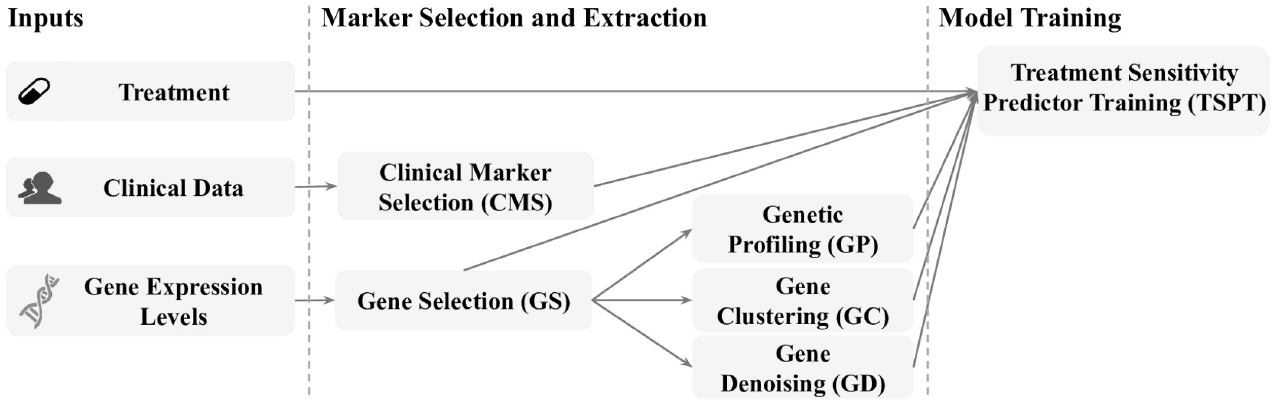
Fig 4. MuLT overview. It inputs clinical markers, gene expression levels, and treatments, performs a set of marker selection and extraction steps, and then creates a TS predictor.